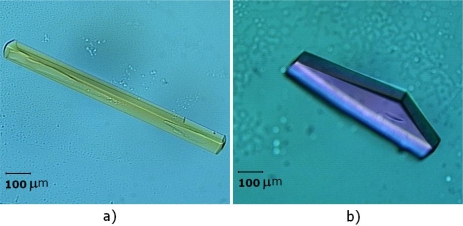
Crystals of BjVIII obtained using the hanging-drop vapour-diffusion method. a) P212121 crystal form and b) P3121 crystal form. Images were recorded using polarized light.